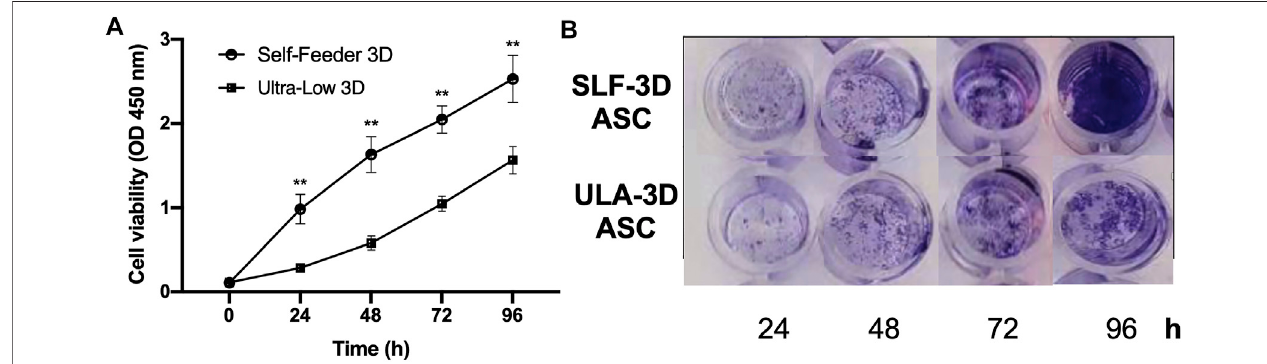
FIGURE 4 | Cell viability of ASCs in SLF-3D and ULA-3D cultures at different time points. (A) Cell counting kit 8 (CKK-8) assay. Cell counting plot for ULA-3D and SLF-3Dspheroids.Graphsshowthemeansofthreeindependentexperiments,eachperformedinduplicate ± SE. n (cid:2) 5;** p < 0.01,ascomparedwithcontrol(0 h)group. (B) Crystal violet stain of SLF-3D and ULA-3D ASC spheroids. (A) After 24, 48, 72, and 96 h, the spheroids were stained with crystal violet and photographed. Crystal violetstaining:Cellswerestainedwithcrystalvioletsolutionfor10 min. Threeindependent experimentswereperformedinduplicate, andrepresentativeresultsare shown. Scale bar, 100 μ m.